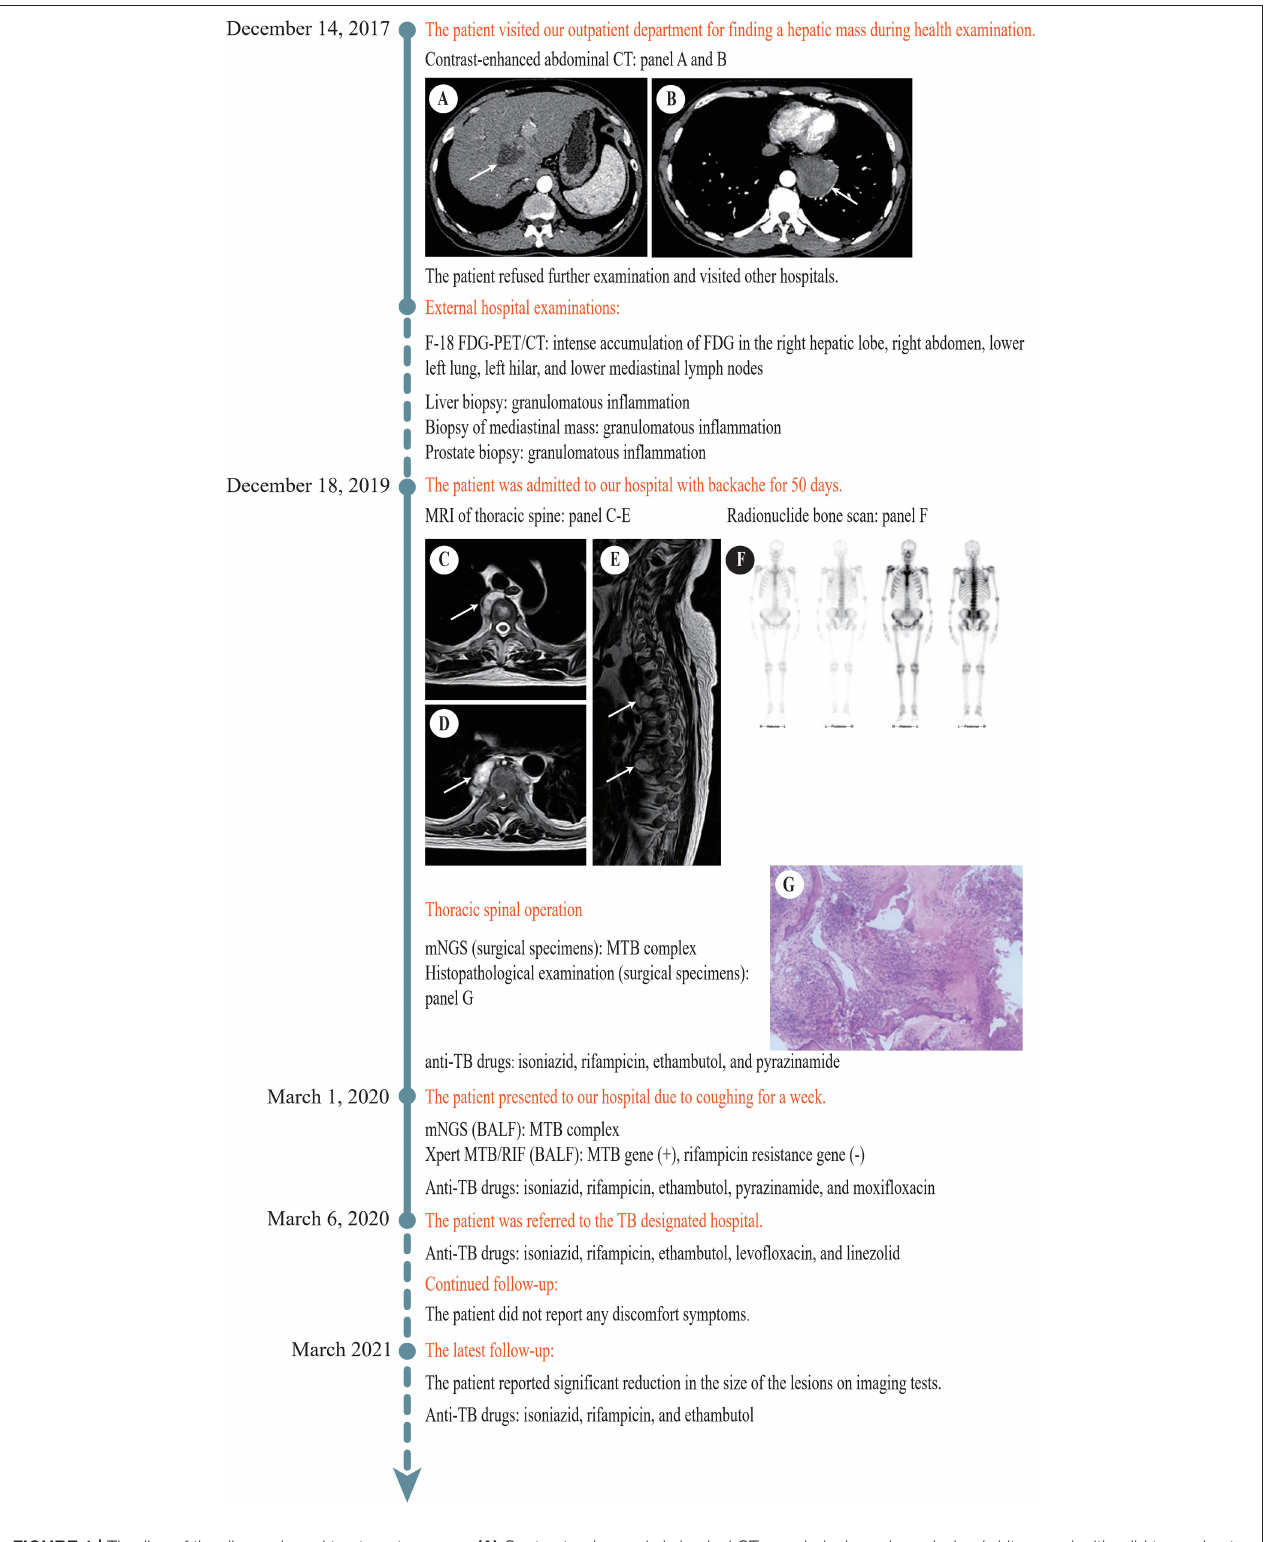
FIGURE 1 | Timeline of the diagnosis and treatment process. (A) Contrast-enhanced abdominal CT revealed a hypodense lesion (white arrow) with mild to moderate enhancement in the right hepatic lobe near hepatic hilar. (B) Contrast-enhanced abdominal CT revealed a soft tissue density lesion (white arrow) with